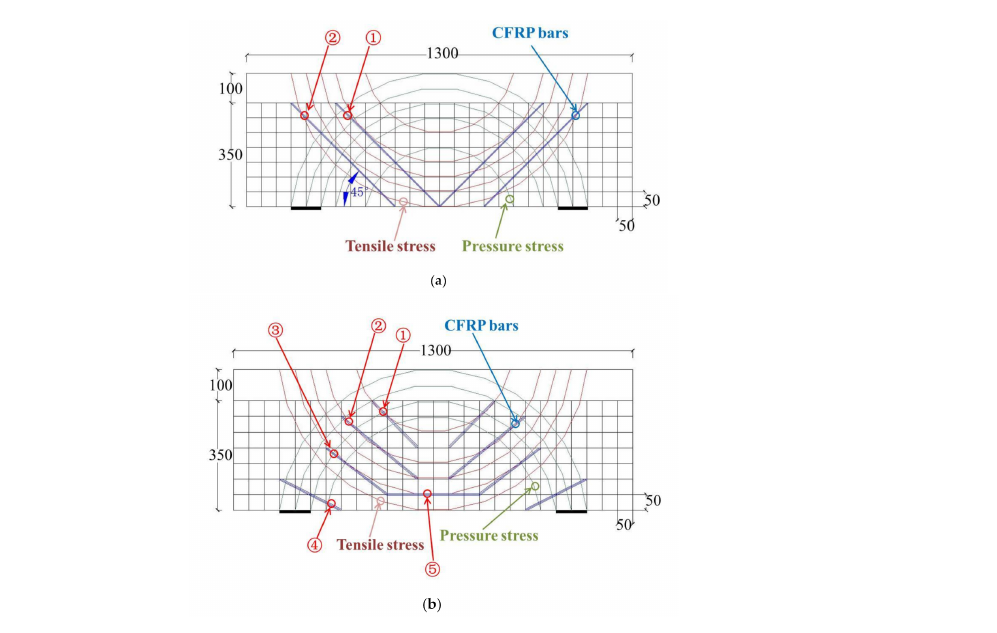
Figure 12. Reinforcement schemes: ( a ) Scheme I. Note: 1 (cid:13) , 2 (cid:13) are CFRP bars; ( b ) Scheme II. Note: 1 (cid:13) , 2 (cid:13) , 3 (cid:13) , 4 (cid:13) , 5 (cid:13) are CFRP bars. Table 8. CFRP bars on the two reinforced schemes (Scheme II).